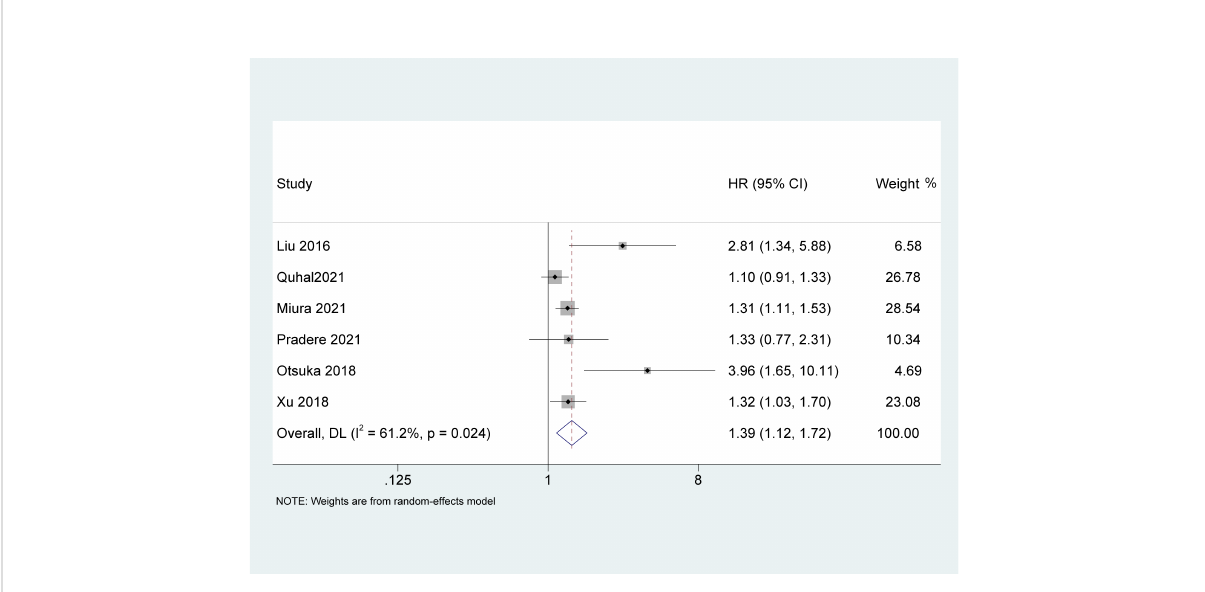
FIGURE 4 Forest plot and meta-analysis of the association between recurrence-free survival and albumin to globulin ratio.